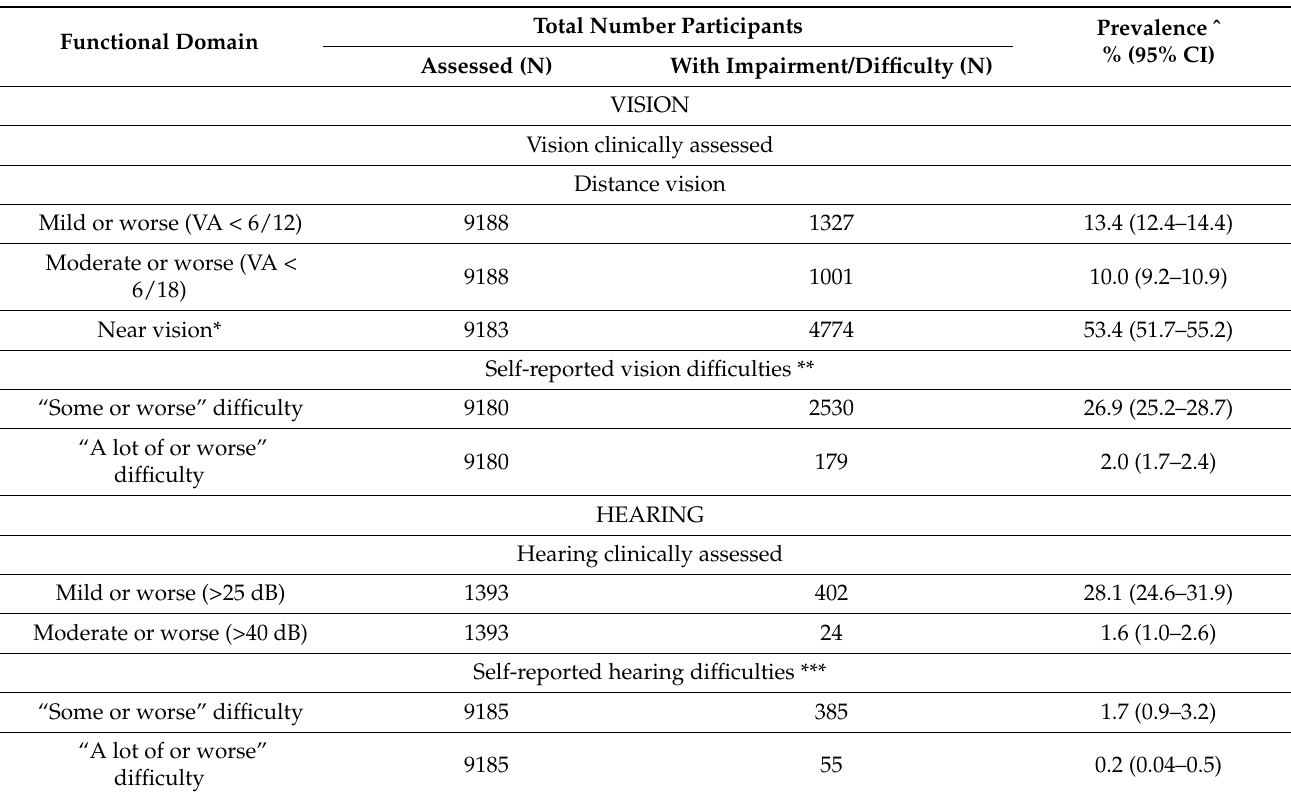
Table 1. Overall prevalence of vision and hearing impairment/difficulty with participants 35+ who completed distance vision, near vision and hearing clinical assessments and self-reported difficulty questioning in The